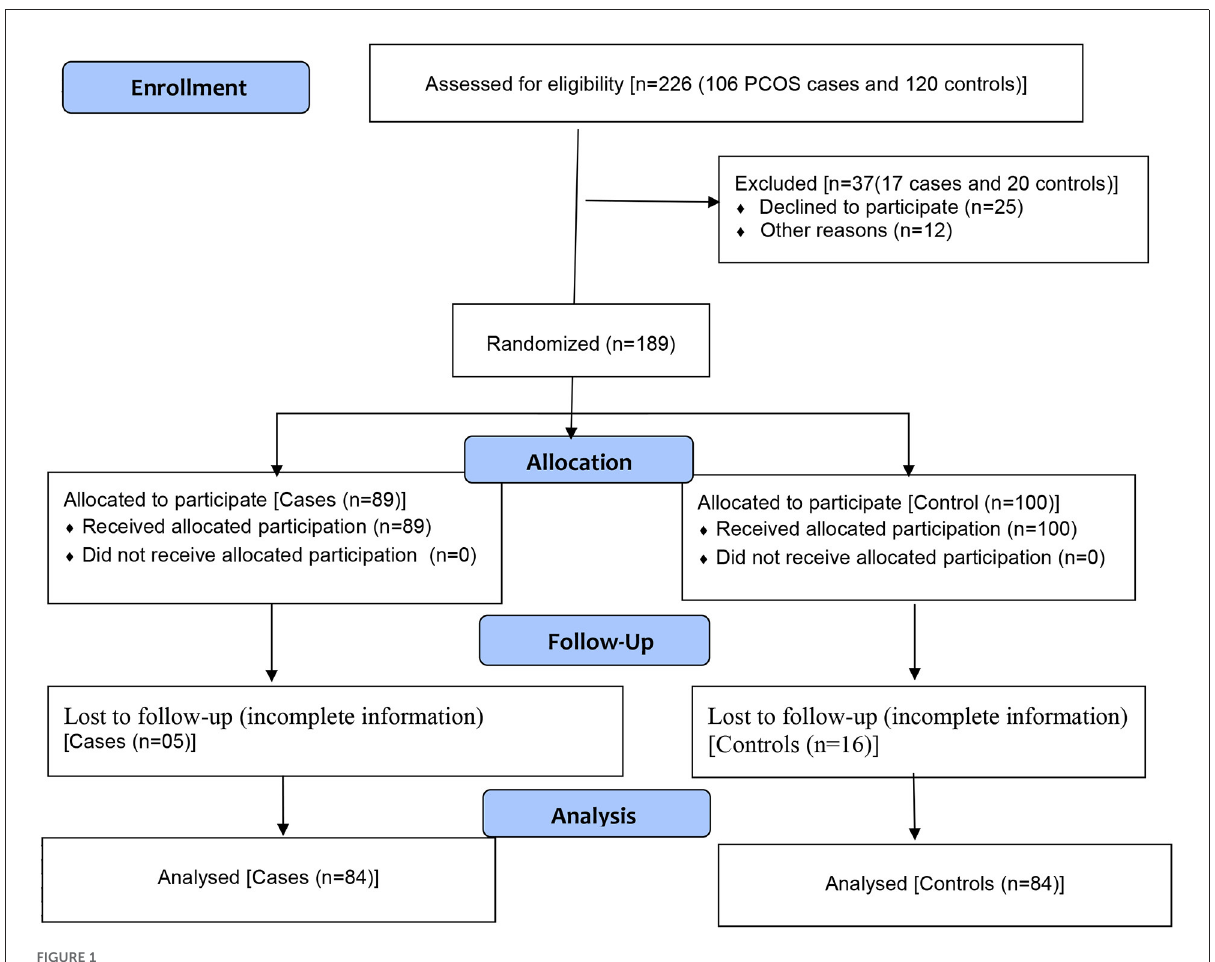
FIGURE1 Flow diagram of the